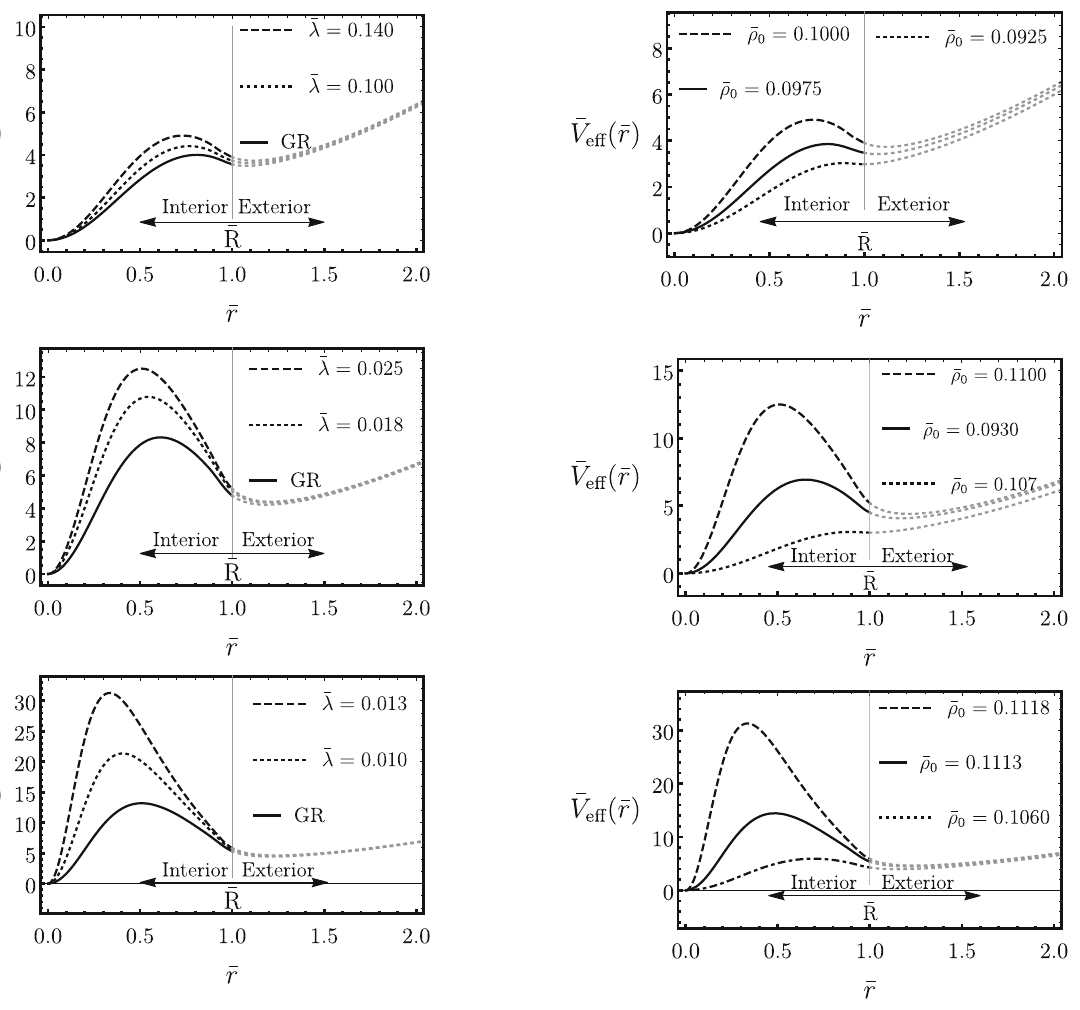
V eff smoothlymatchestheeffectivepotentialfornullgeodesics